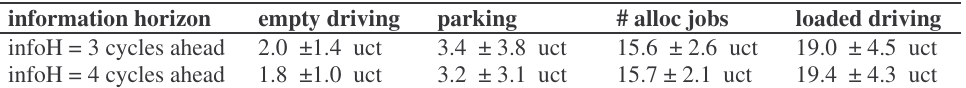
Table 8. Simulation results of the procedure of job assignment information